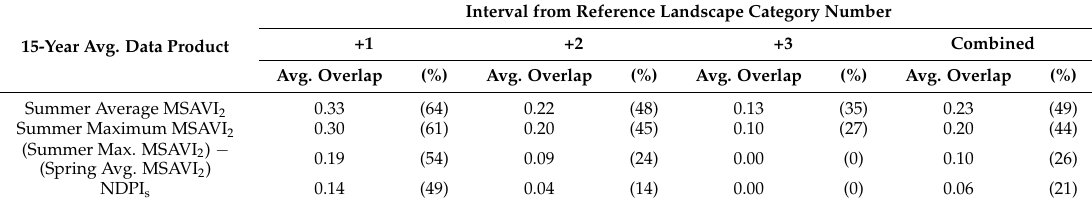
Table 3. Average Overlap of the Ranges of Normalized Data Values among Landscape Categories for Individual and Combined Category Intervals.